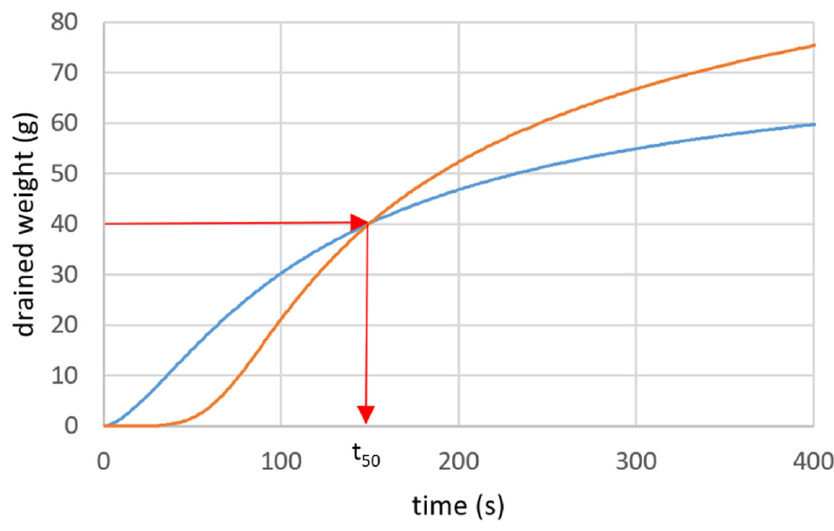
Figure 5. Two different foam decay processes (one described by the blue line and the other by the orange one) that exhibit the same half-life time.